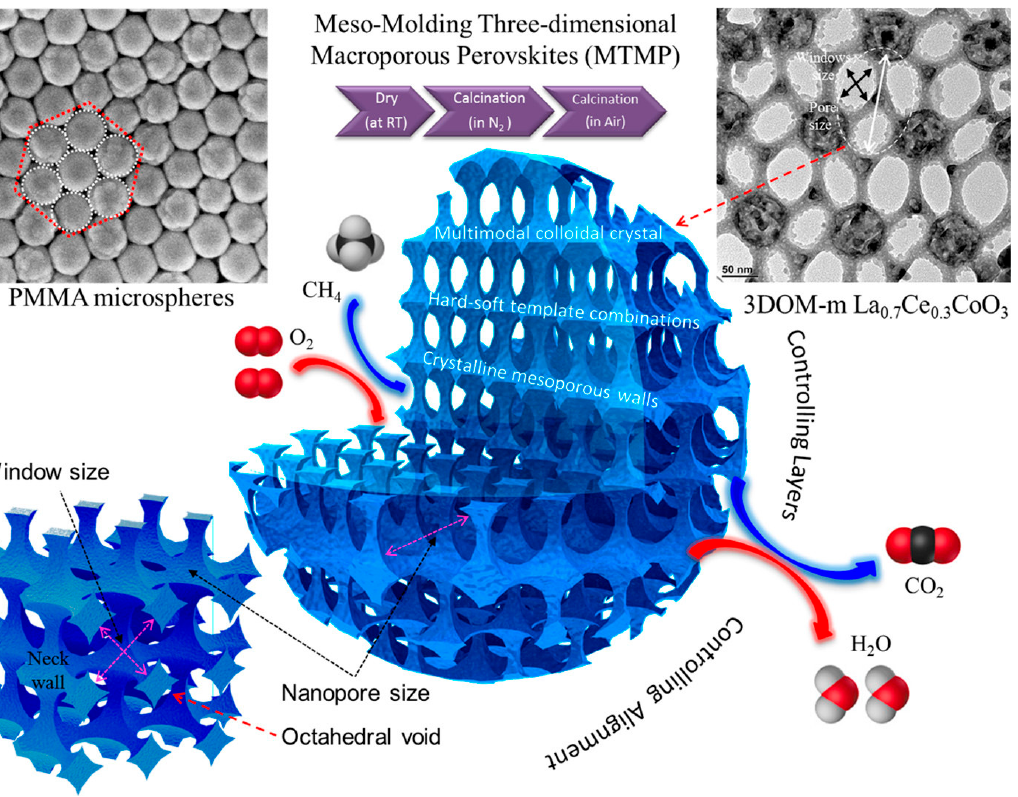
Figure 5. Schematic illustration of the 3DOM-m La 1– x Ce x CoO 3 catalysts. Reprinted with permission from Ref. [60]. Copyright 2015, copyright American Chemical Society.